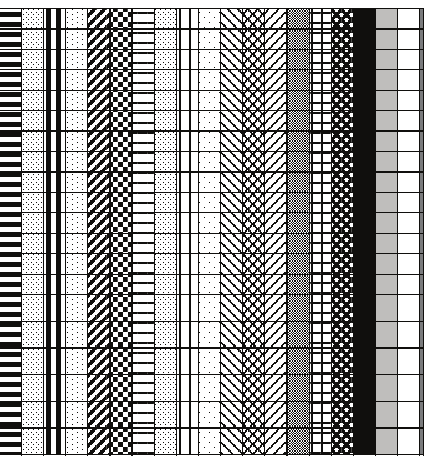
Figure 6: Schematic drawing of coherent destroying di ff user. (Patterns correspond to the phase values listed in Table 1.)